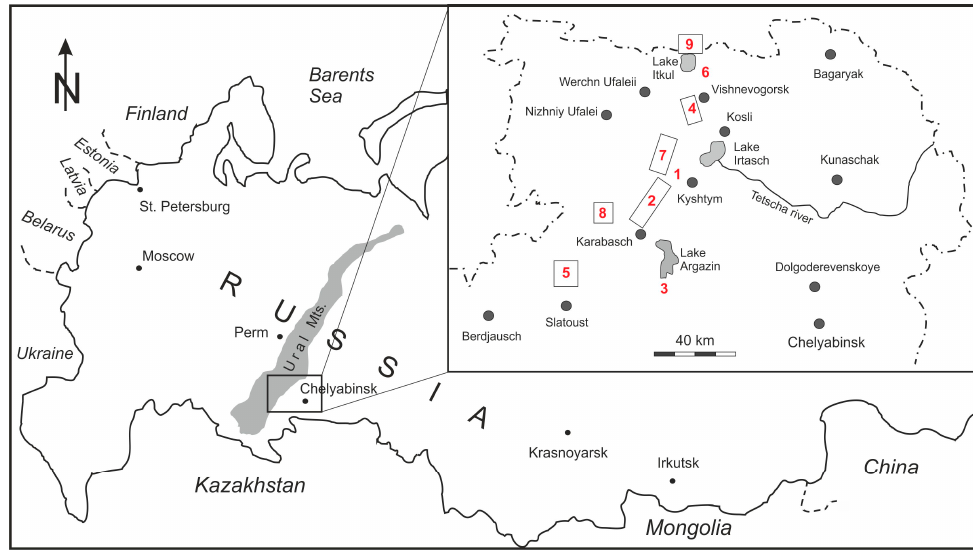
Figure 1. Topographic sketch showing the investigated quartz occurrences of the Southern Ural region northwest of Chelyabinsk (Russia); 1—Berkutinskaya (Berkut), 2—Kyshtym (sample Ky-175), 3—Argazinskoe (Arg), 4—Vjasovka (Vja), 5—Itkulskoe (Itkul), 6—Bolotnaya (Bol), 7—Kuznechikhinsk (Ku-414, Ku-2136), 8—Yurma ridge (Yur), and 9—Taganai ridge (MT-09). Numbers relate to the locations and quartz types in Table